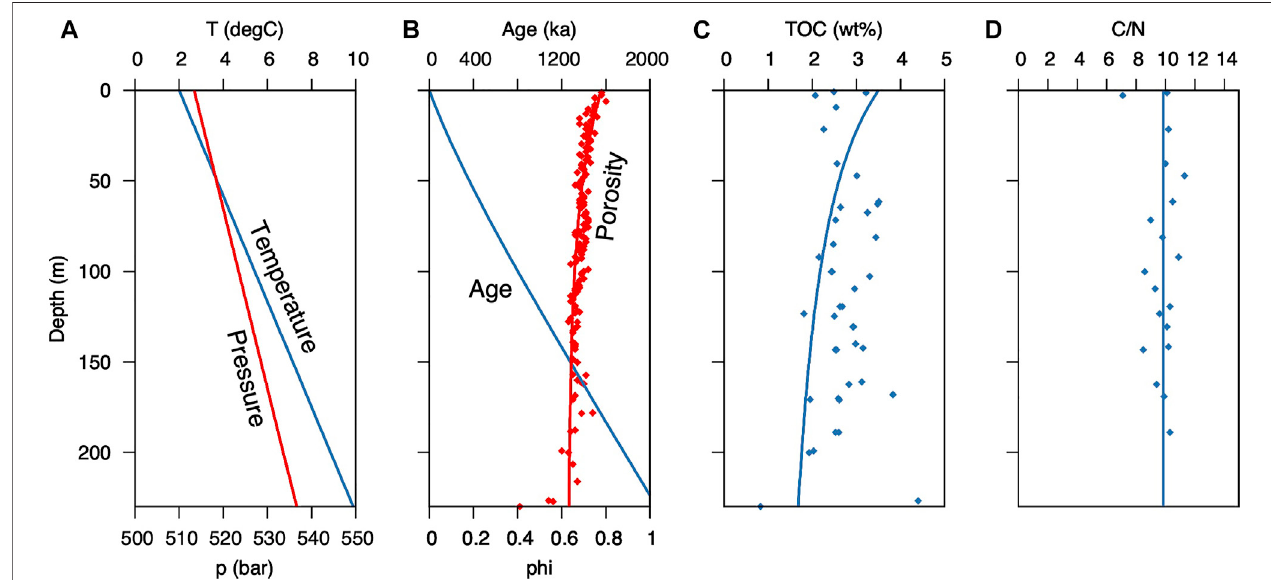
FIGURE 4 | Sediment properties and organic matter content vs. depth at ODP Site 1230: (A) porewater temperature and hydrostatic pressure; (B) sediment age and porosity (data from D ’ Hondt et al., 2003); (C) total organic carbon content (data from Meister et al., 2005); (D) measured C/N ratios from Site 1230 (Prokopenko et al., 2006). The solid lines indicate the values assumed for the